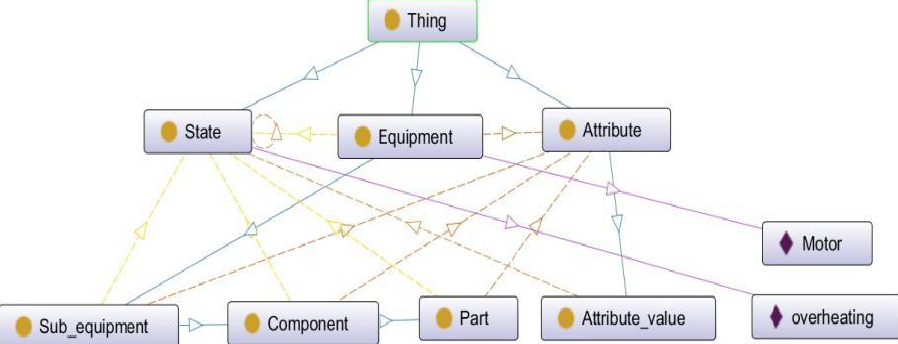
Figure 1. mechanical fault detection ontology construction schematic.